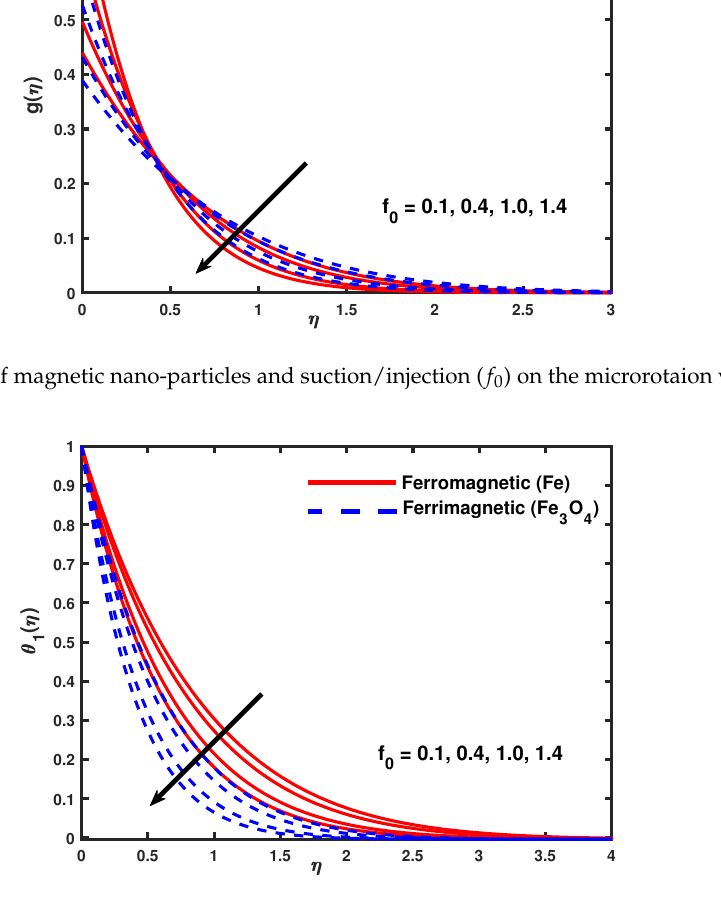
Figure 4. Impact of magnetic nano-particles and suction/injection ( f 0 ) on the temperature profile θ 1 ( η )